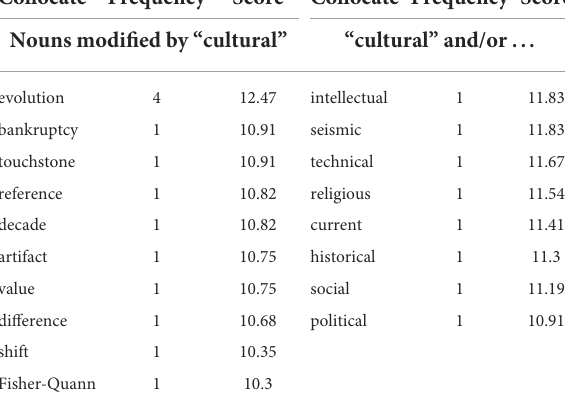
TABLE 5 Collocates of “cultural” in the English subcorpus. Collocate Frequency Score Collocate Frequency Score “cultural” and/or ...